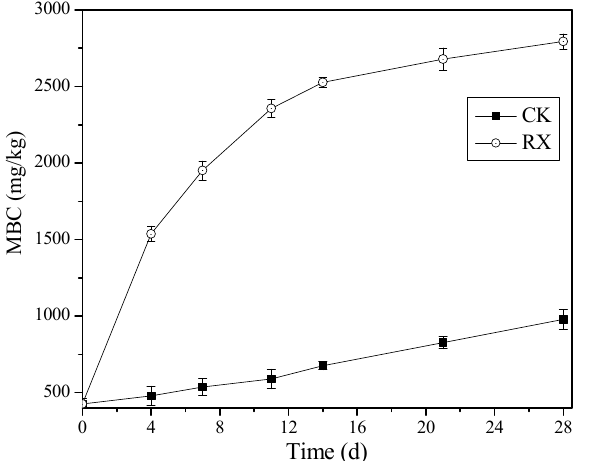
Figure 7. Change of MBC in BR with (RX) and without (CK) the application of ZH-1. These results are presented as mean ± standard deviation ( n = 3).